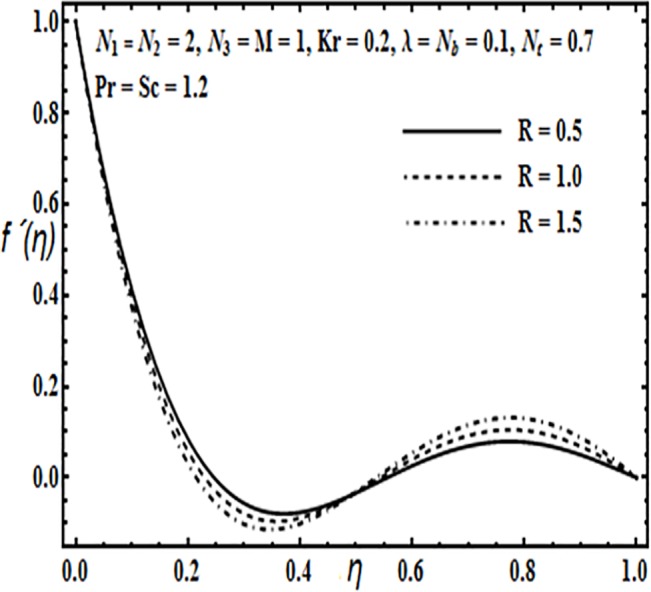
Effect of R on f′(η).